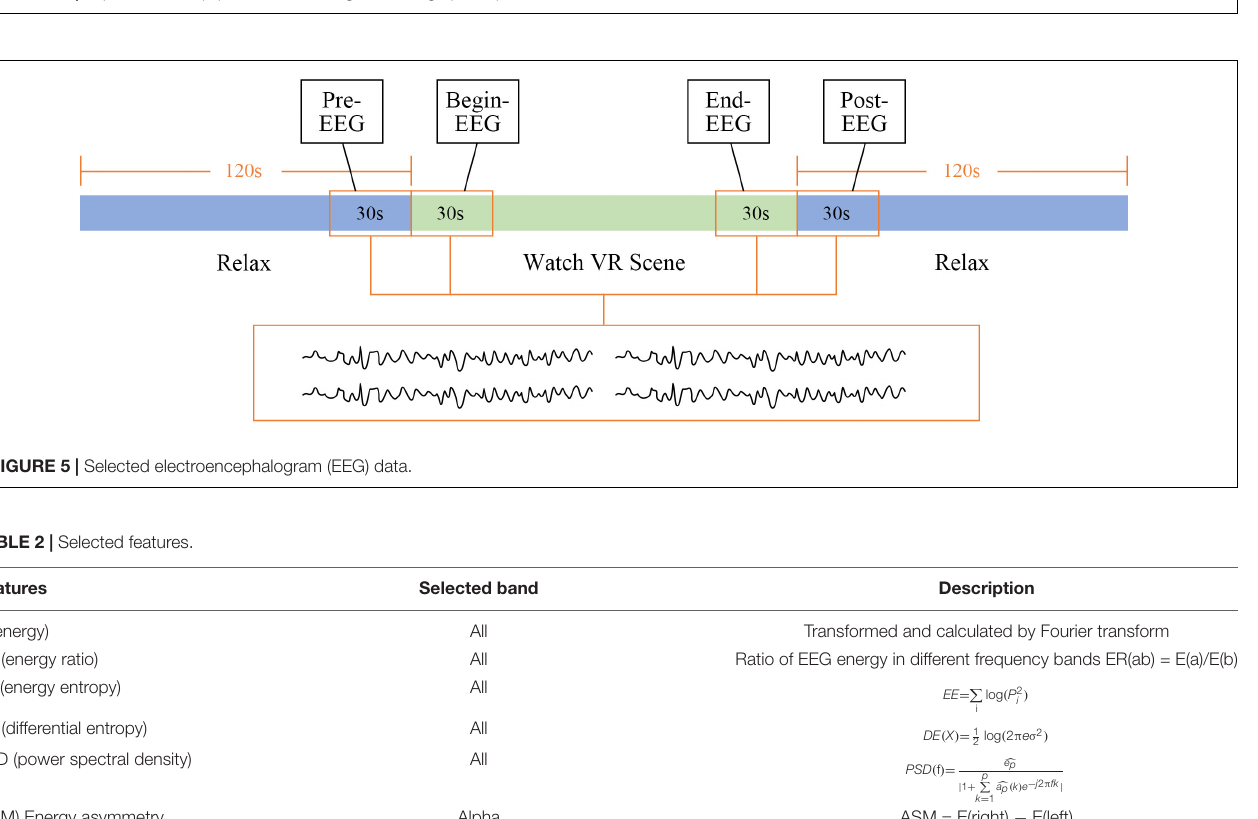
FIGURE 4 | Experimental equipment and settings for college participants.